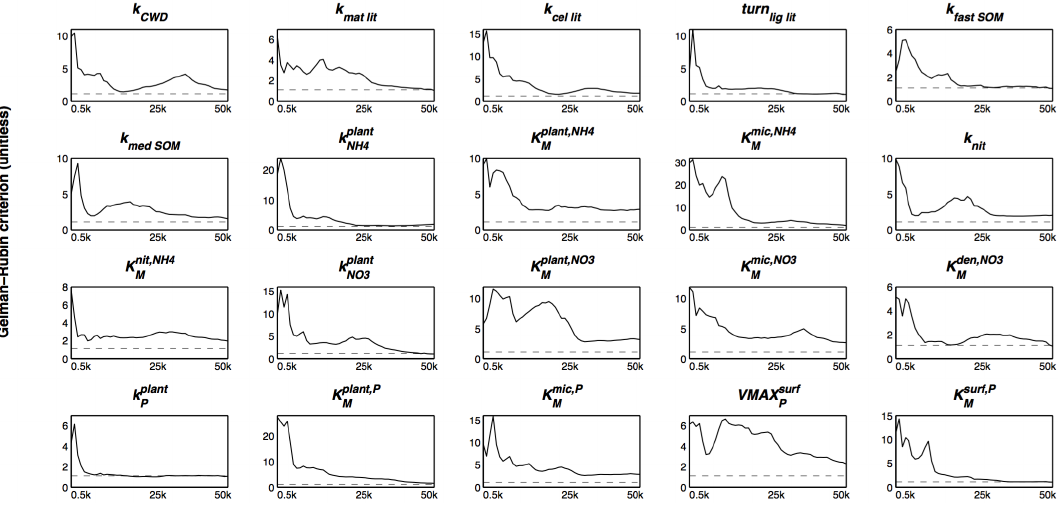
Figure A2. Gelman–Rubin convergence criterion (solid lines) calculated from three chains in Fig. A1. Baseline value is set to 1.1 (dashed lines). When the Gelman–Rubin criterion is smaller than or equal to 1.1, the chains are thought to